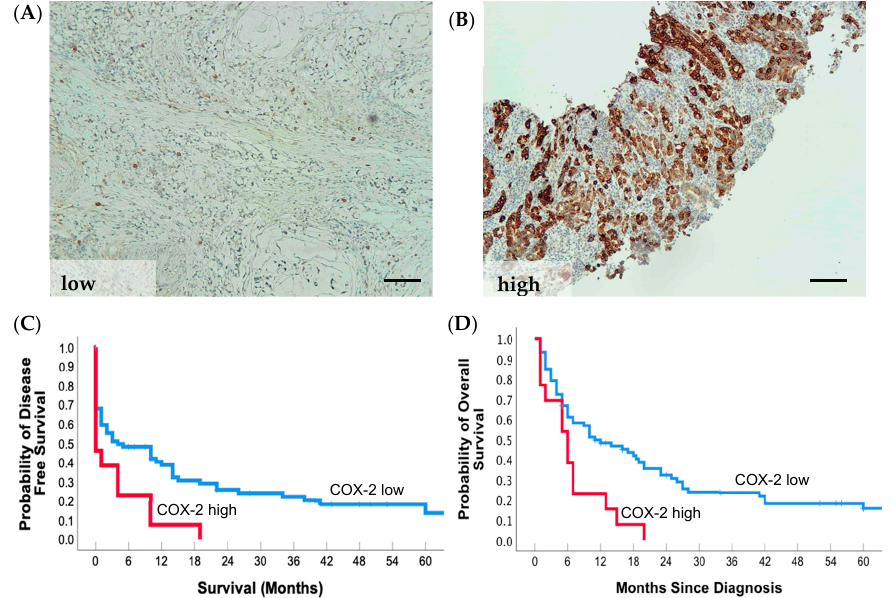
Figure 3. High COX-2 expression in gastric tumors correlates with reduced disease-free and overall survival in AN gastric cancer patients. Representative COX-2 protein expression ( A ) low and ( B ) high in gastric cancer tissue. ( C ) 5-year disease-free survival rate of patients with COX-2 high ( n = 13) or low ( n = 72) expressing tumors, p = 0.01. ( D ) 5-year overall survival rate of patients with COX-2 high ( n = 13) or low ( n = 72) expressing tumors, p = 0.004. Scale bars; 100 μ m. Table 6. Univariate analyses for overall survival in Alaska Native gastric cancer patients.